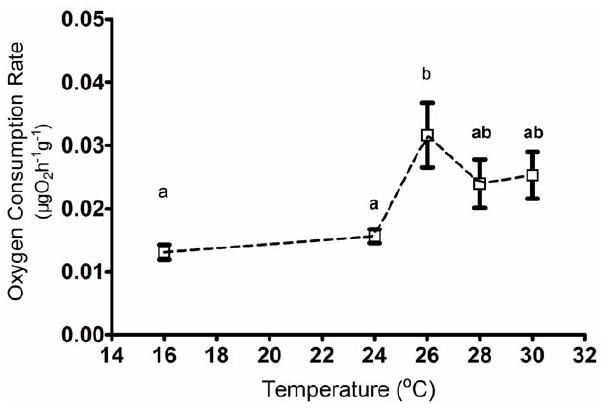
Figure 1. The peak values of oxygen consumption in different temperature treatments (24, 26, 28, and 30 6 C). Different letters indicate significant difference ( P , 0.05).